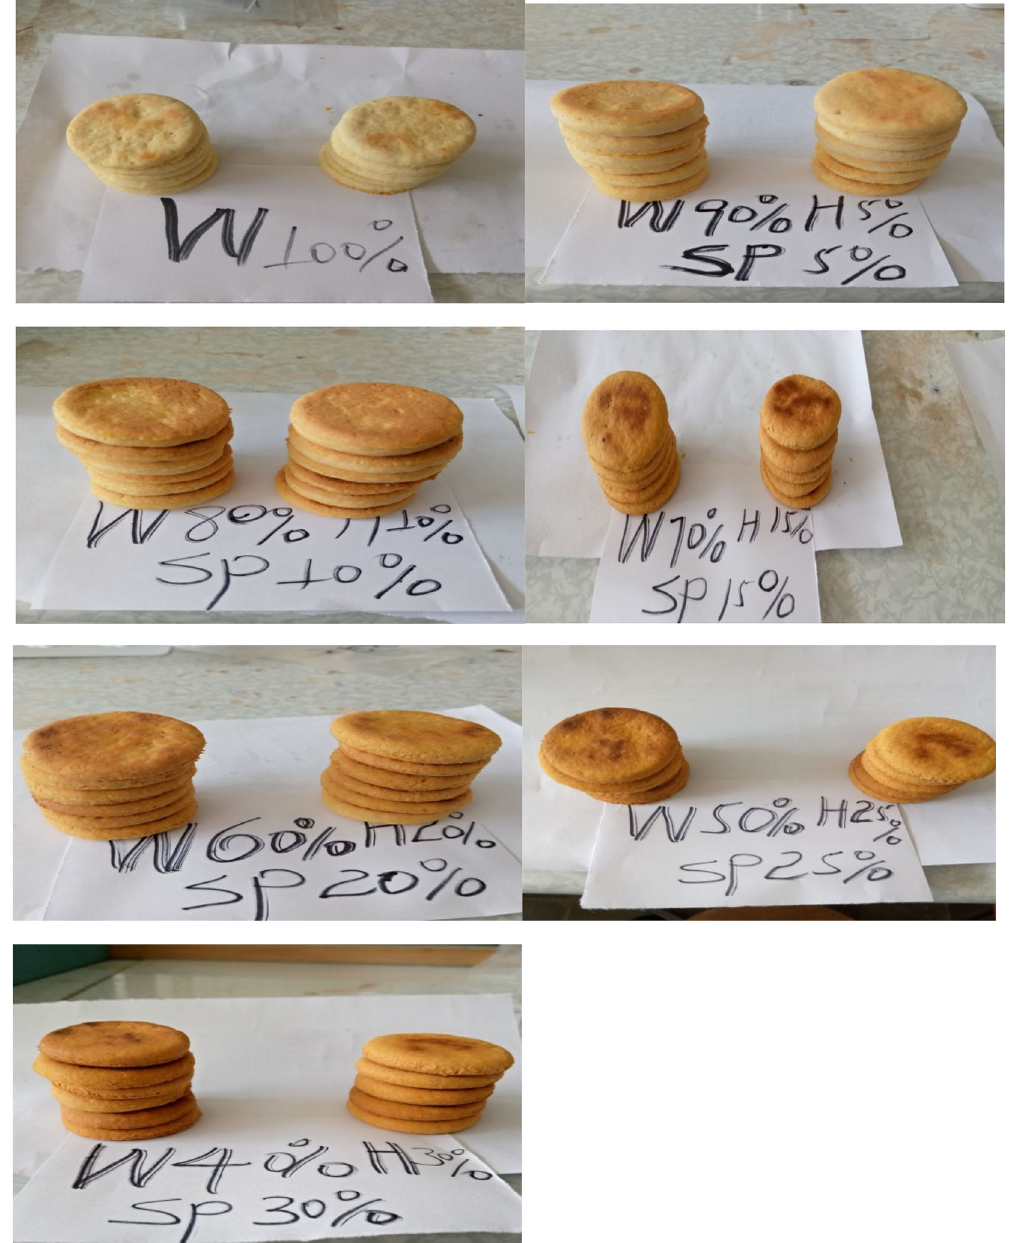
Figure 2. Diagrammatic pictures of biscuits prepared from blending of wheat, OFSP and Haricot bean with different